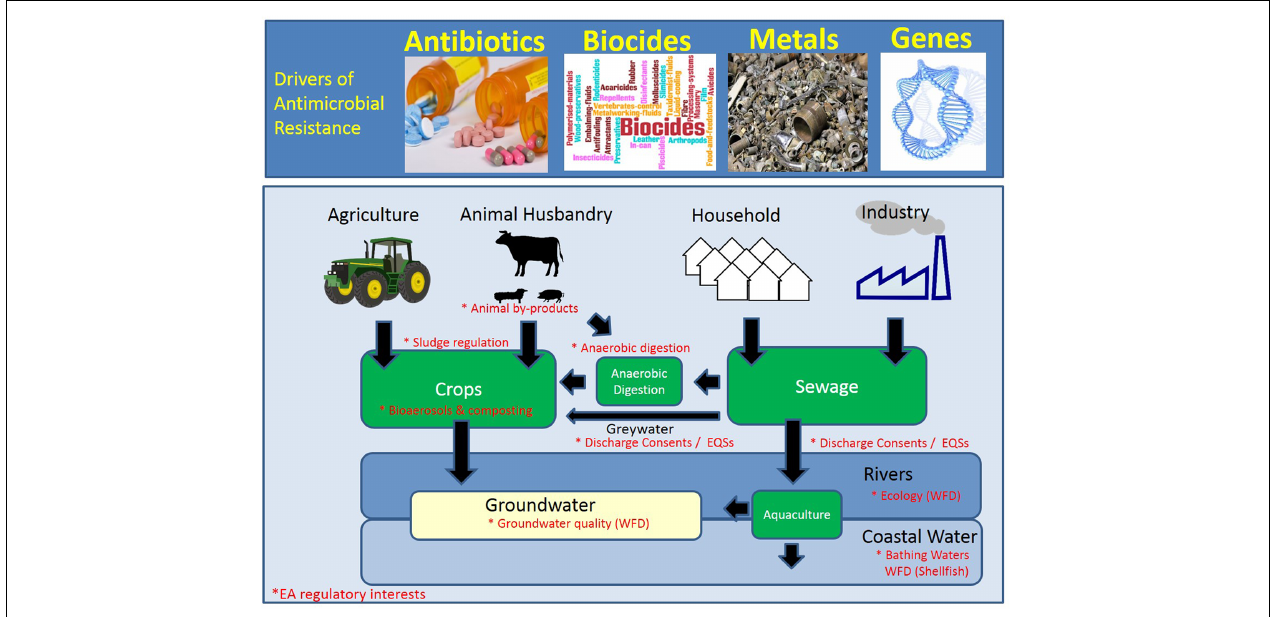
FIGURE 1 | Schematic of the hot-spots and drivers of antimicrobial resistance (AMR). The environmental compartments that are currently monitored or regulated by the Environment Agency (EA; England) are denoted by an asterisk in red. WFD, Water Framework Directive.